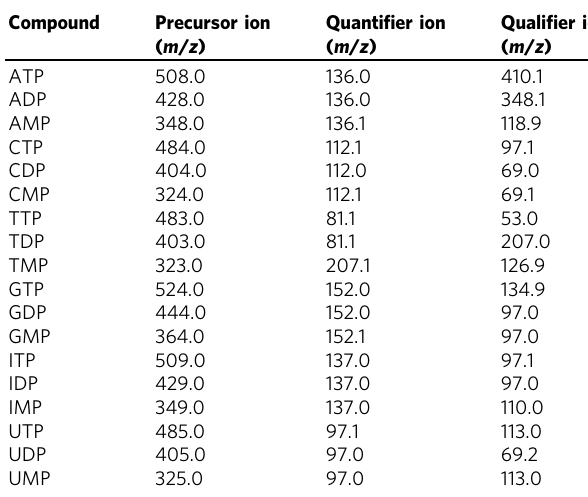
Table 2 Agilent 6430 Triple Quadrupole MRM transitions